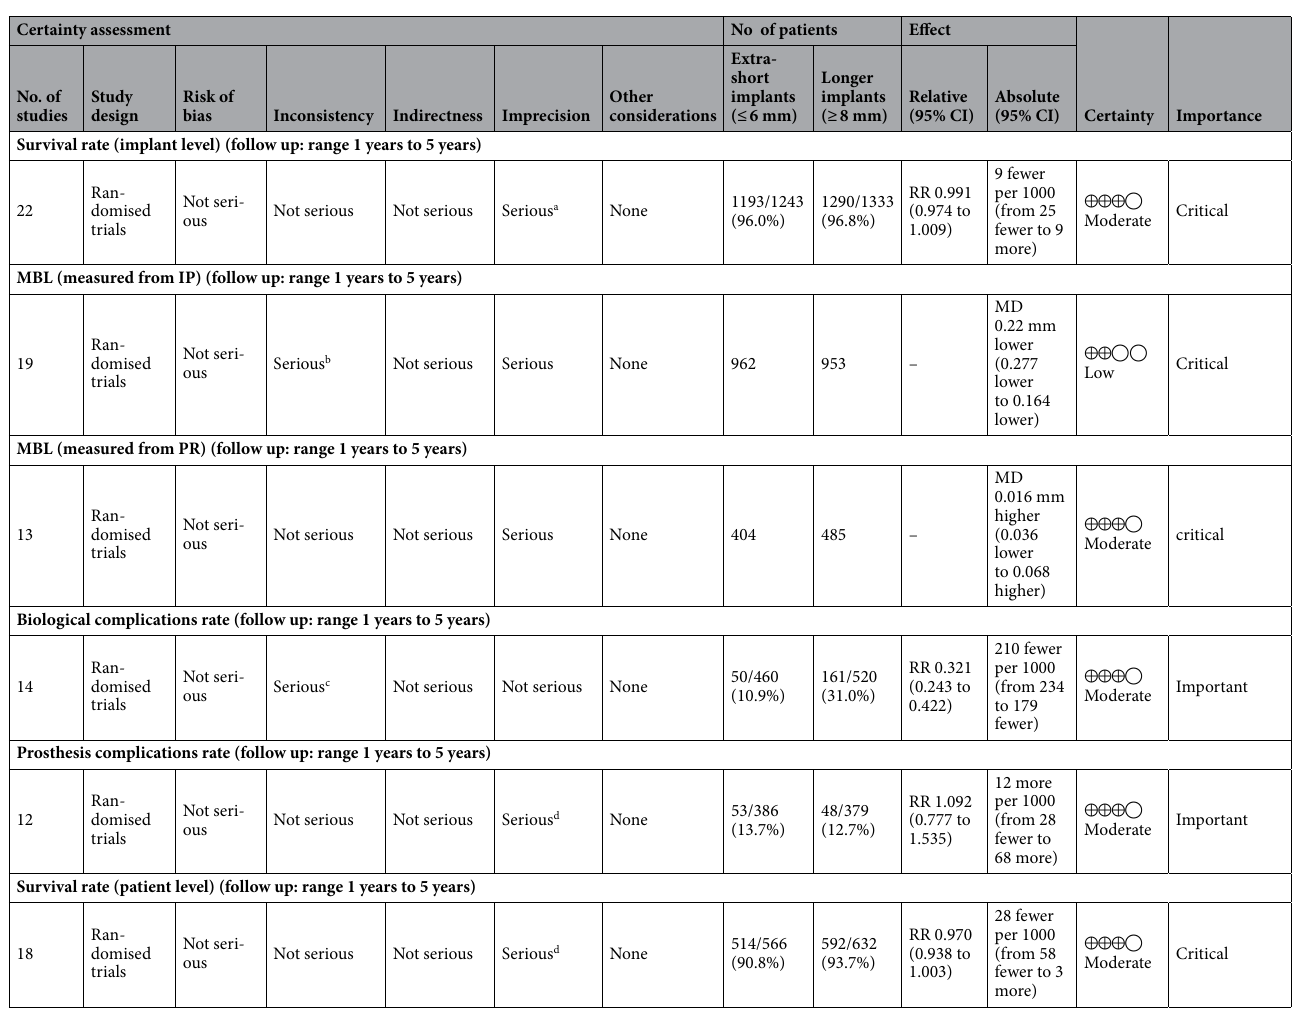
Table 3. Grades of recommendation, assessment, development and evaluation approach summarizing the evidence. Question: Extra-short implants (≤ 6 mm) compared to longer implants (≥ 8 mm) for partially or totally edentulous patients. GRADE Working Group grades of evidence. High certainty: We are very confident that the true effect lies close to that of the estimate of the effect. Moderate certainty: We are moderately confident in the effect estimate: The true effect is likely to be close to the estimate of the effect, but there is a possibility that it is substantially different. Low certainty: Our confidence in the effect estimate is limited: The true effect may be substantially different from the estimate of the effect. Very low certainty: We have very little confidence in the effect estimate: The true effect is likely to be substantially different from the estimate of effect. Generated by GRADEpro GDT web application, http:// grade pro. org. CI: confidence interval; RR: risk ratio; MD: mean difference. a Small simple size (less than OIS), CI of RR included 1. b Heterogeneity across